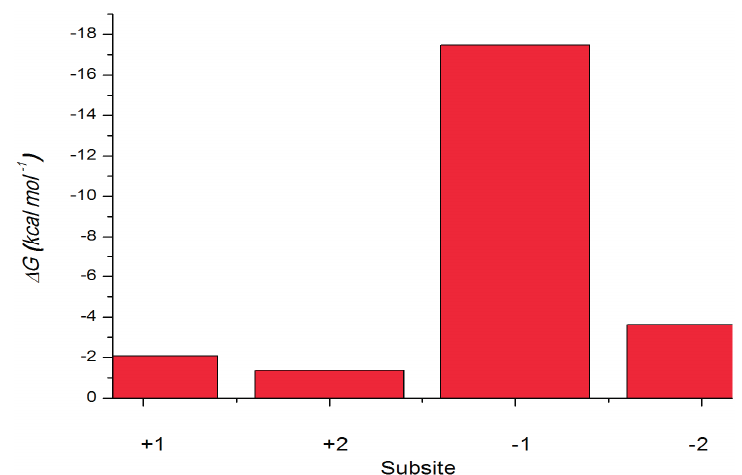
Figure 9. Internal molecular mechanical energies of xylose monomers in the enzyme. Energies of X4(sb) are shown with red (enzyme)